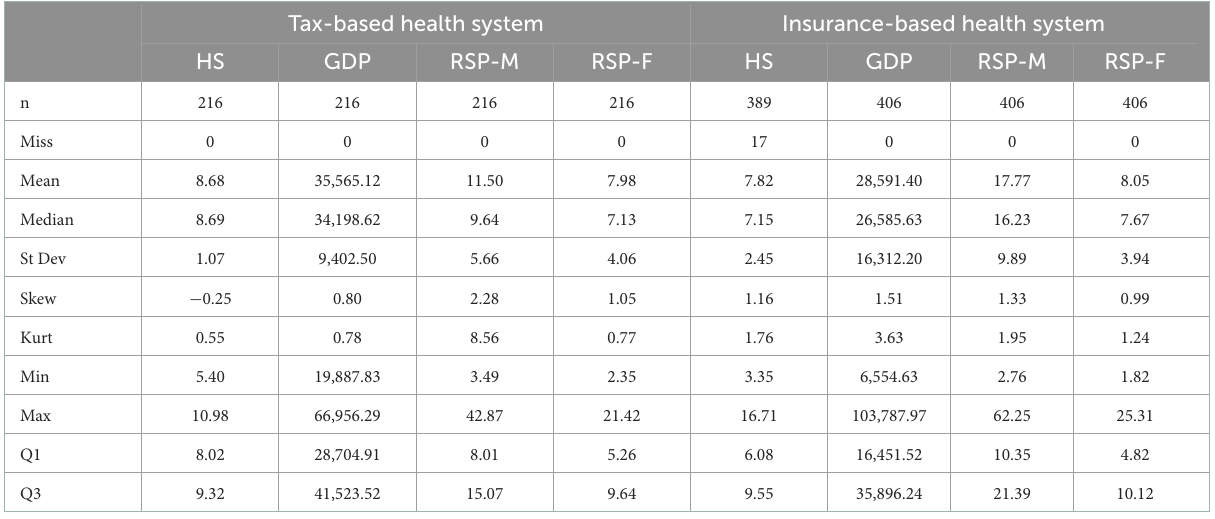
TABLE 1 Descriptive statistics of economic indicators and treatable mortality from respiratory system diseases classified by gender and health system. Tax-based health